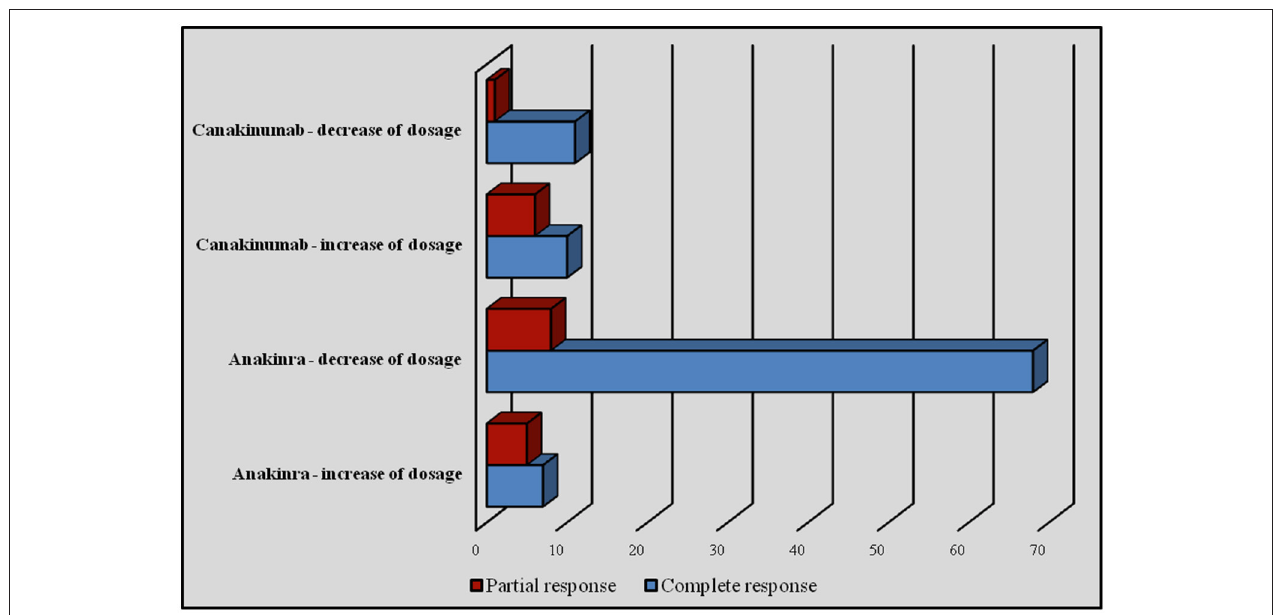
FIGURE 9 | Number of patients undergoing an increase or decrease of IL-1 INH dosage with related clinical outcome.